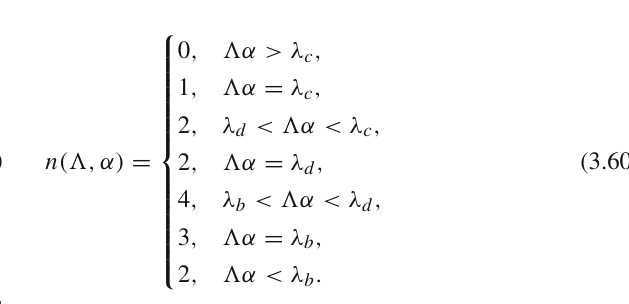
Fig. 2 The function λ( x ) = (cid:2)( x )α for α > 0, l = 4 minimum. We